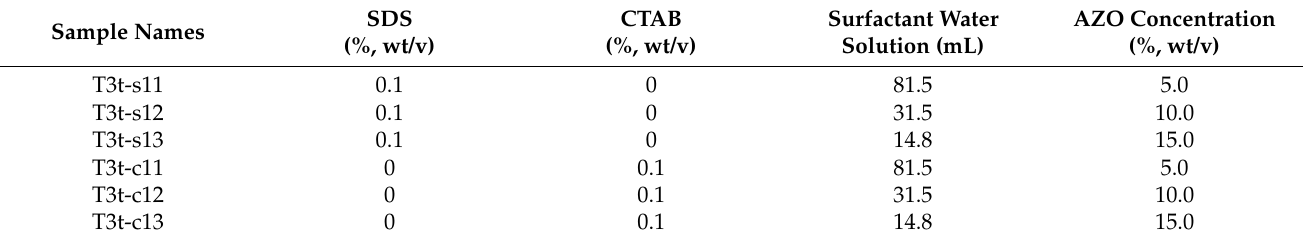
Table 4. Emulsifier and oil/water ratio for AZO-loaded NPs